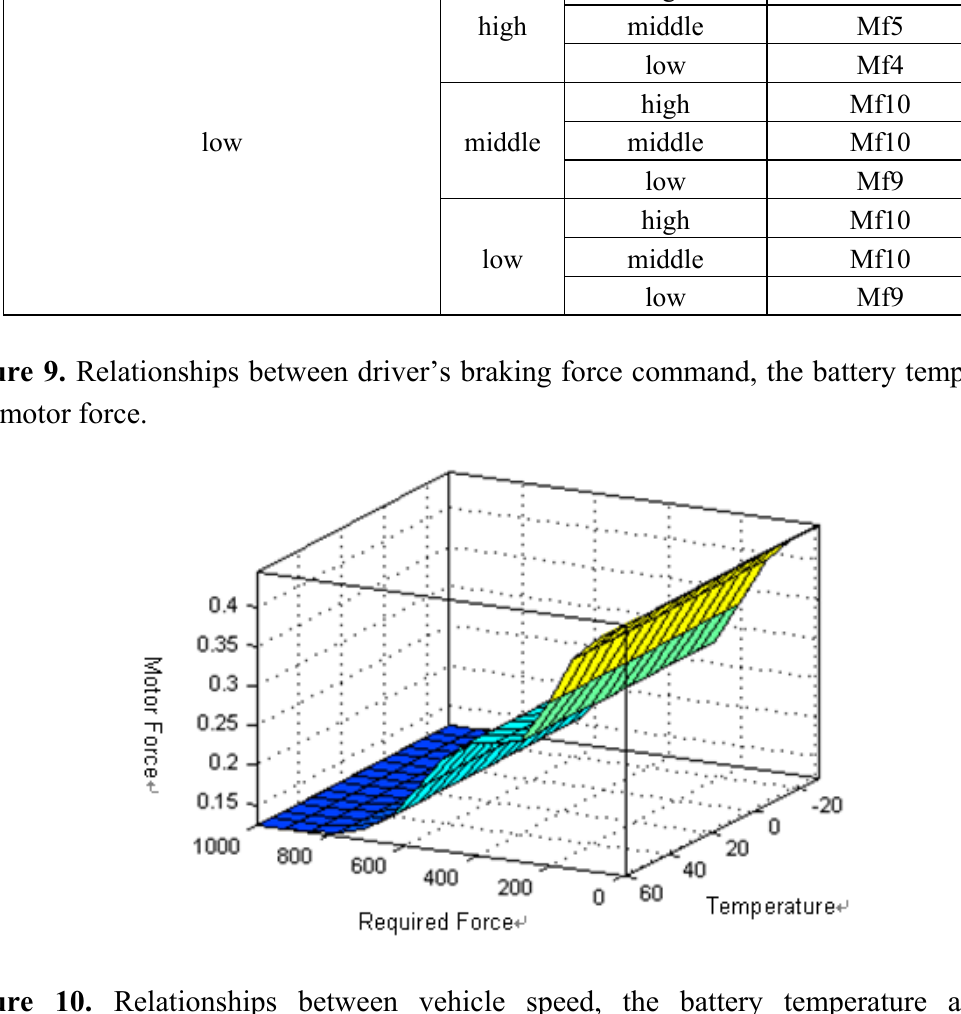
Figure 10. Relationships between vehicle speed, the battery temperature and the motor